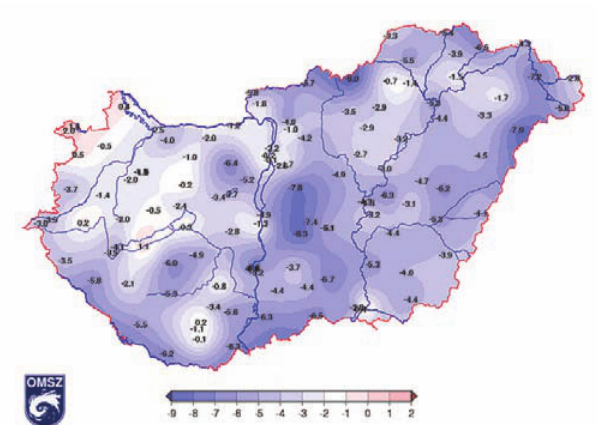
Figure 1 – Minimum temperatures in Hungary at the dawn of coldest day April 10, 1012 (Source: OMSZ)